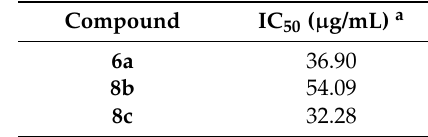
Table 3. Cytotoxic activity of compounds 6a, 8b and 8c on the HEK 293T cells.